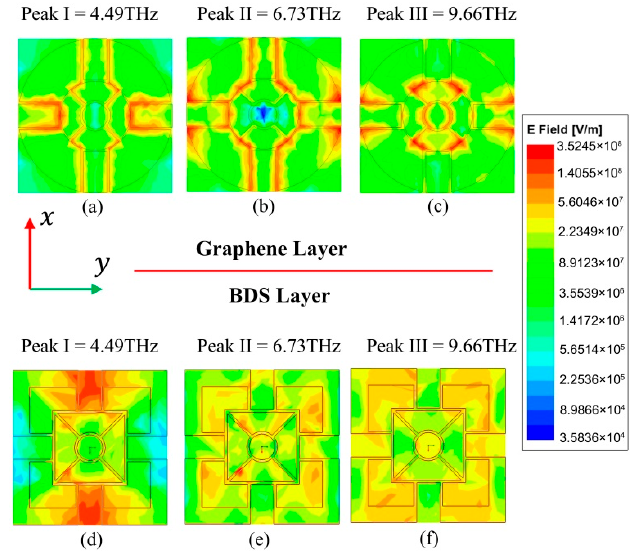
Figure 7. Absolute electric field distributions of graphene at ( a ) 4.49 THz, ( b ) 6.73 THz, and ( c ) 9.66 THz. Absolute electric field distributions of BDS at ( d ) 4.49 THz, ( e ) 6.73 THz, and ( f ) 9.66 THz.